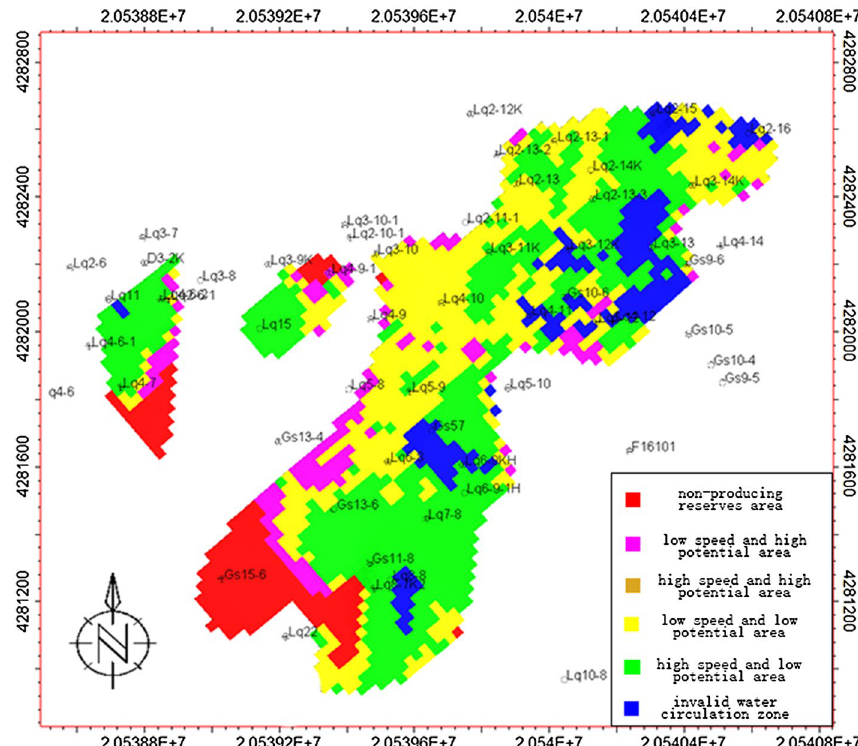
Fig. 10 Gang Dong oilfield Nm3-4-1 layer seepage field schematic diagram before